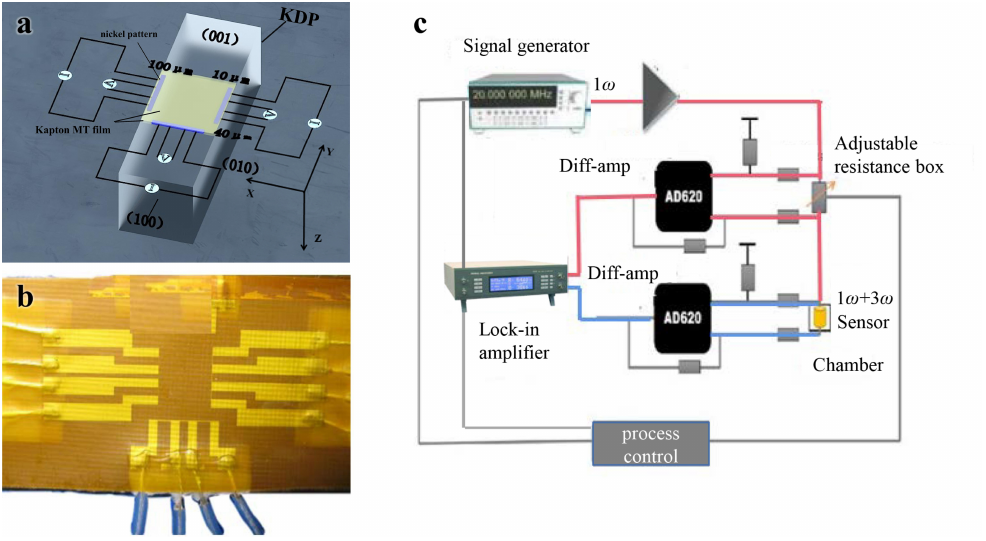
Figure 1. ( a ) Schematic diagram of three sensor on a KDP sample of different widths (100, 40, and 10 µm) that was 150 nm thick and 200 µm wide. ( b ) Photo of the freestanding flexible sensor. ( c ) The key components of the measurement system including signal generator, phase-locked amplifier, adjustable resistance, control circuit, and freestanding flexible